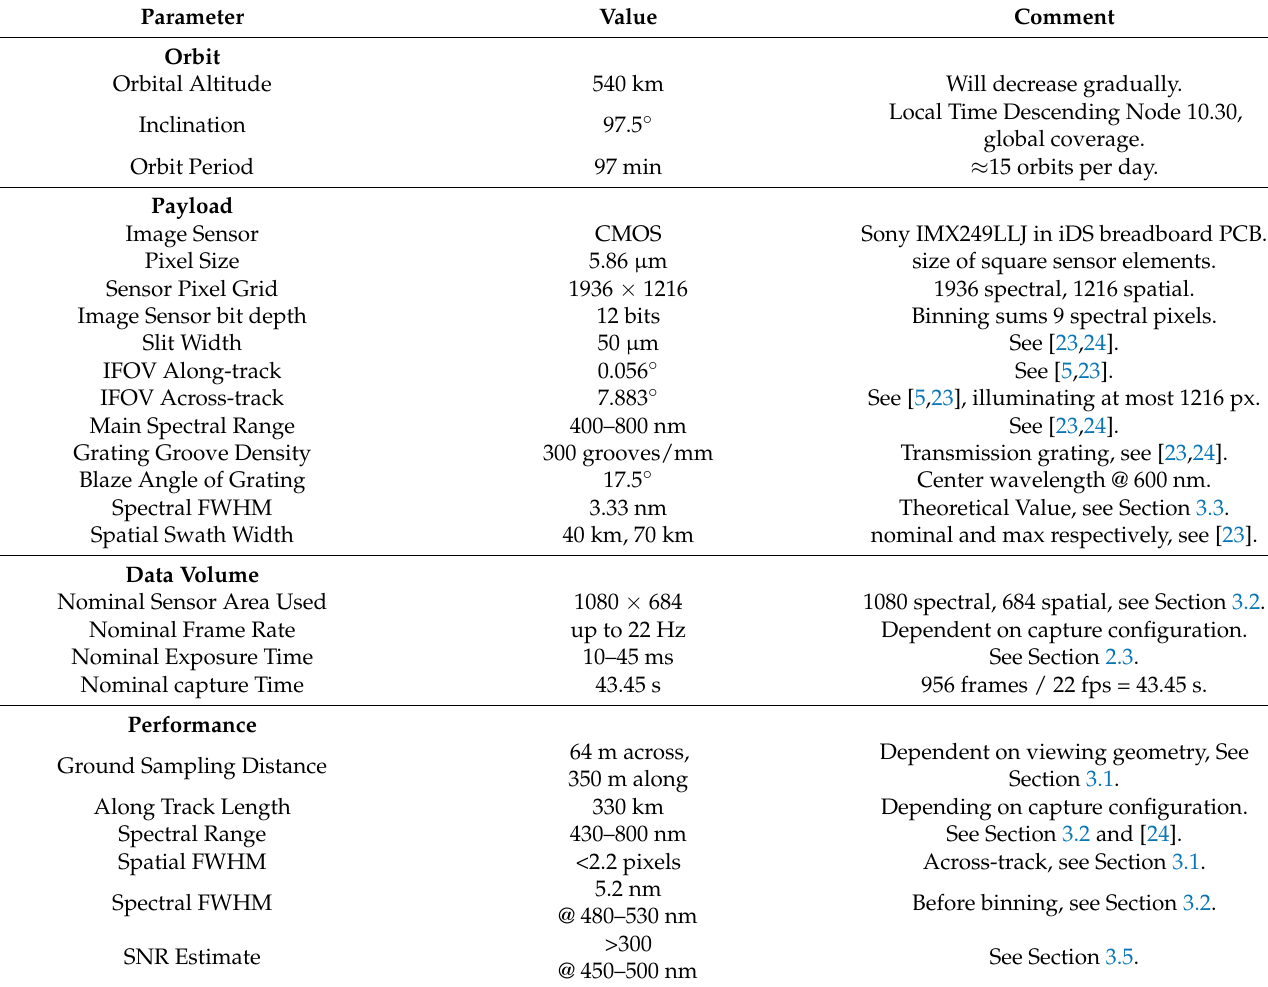
Table 1. An overview of HYPSO-1 parameters. Certain values were originally discussed in